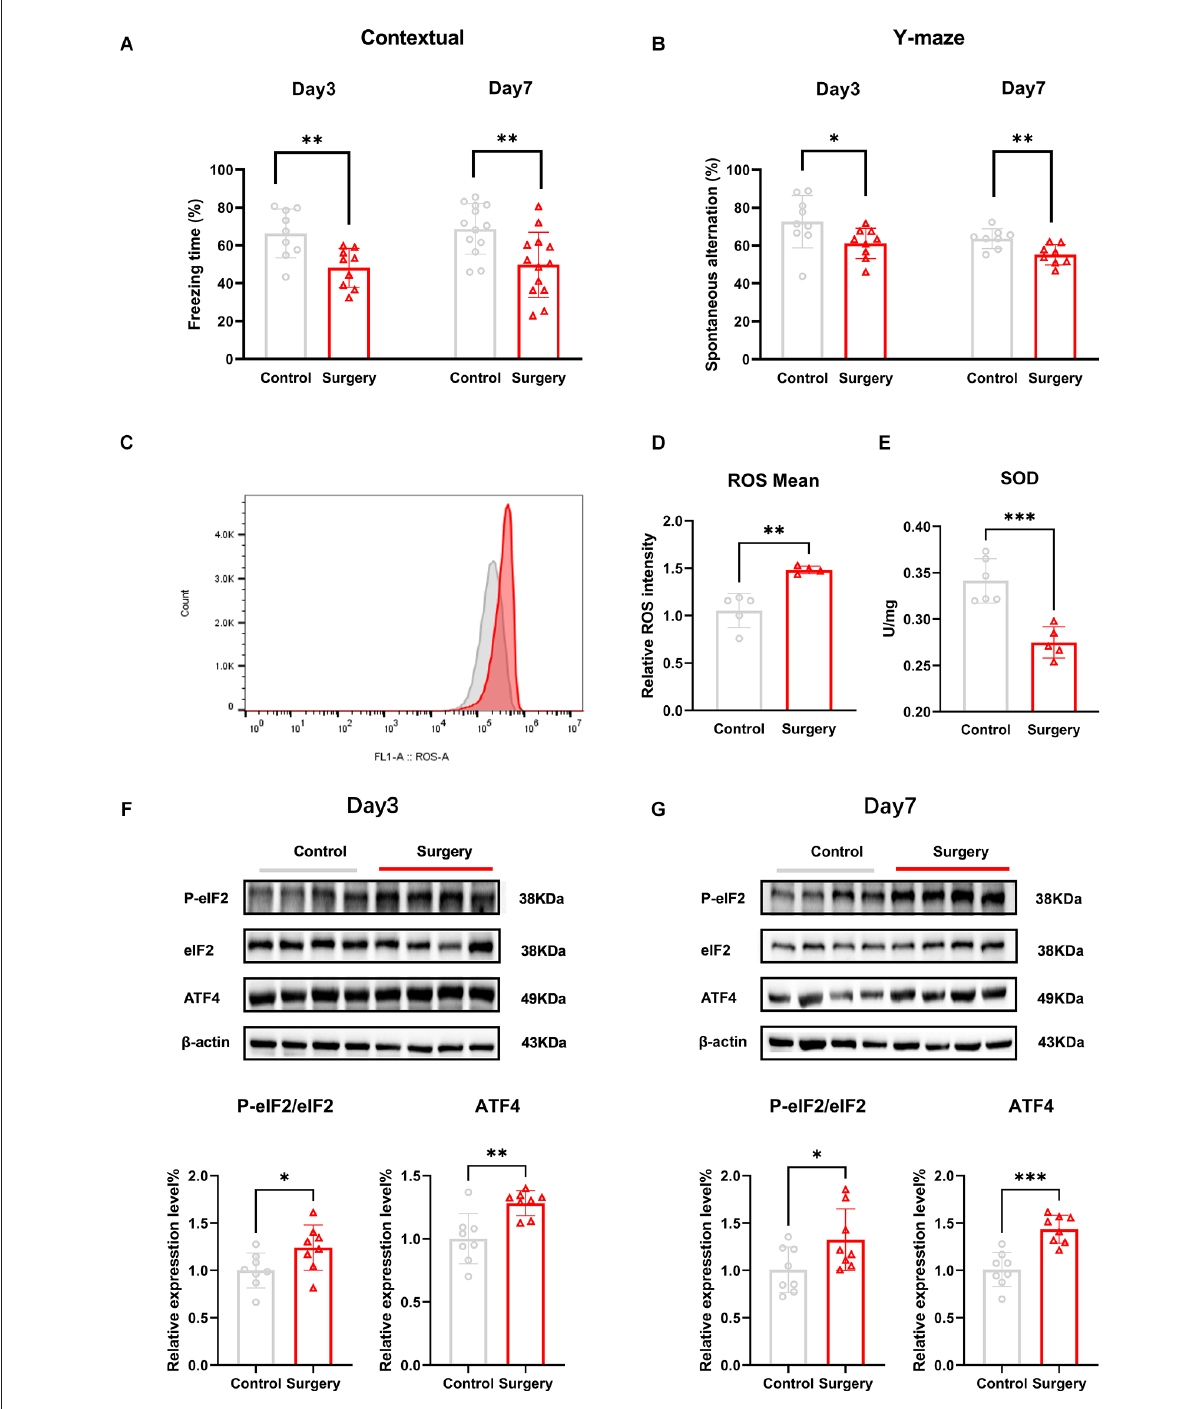
FIGURE1 Tibial fracture surgery induces cognitive decline, accompanied by oxidative stress damage, and ISR activation in the hippocampus of POCD mice. (A) Freezing percentage in the contextual fear conditioning experiment on post-surgery days 3 and 7; the freezing time percentage was significantly reduced in the surgery group compared with the control group. (B) Spontaneous alternation was significantly decreased in the Y-maze on days 3 and 7 following tibial fracture surgery. (C) The average fluorescence intensity of the ROS level increased in the hippocampus of POCD mice on post-surgery day 3, in which red represents the surgery group and gray represents the control group. (D) Histogram quantification of ROS average fluorescence intensity of (C) . (E) The SOD level is decreased in the hippocampus of POCD mice on post-surgery day 3. (F) POCD increased eIF2 α phosphorylation and ATF4 protein levels at post-surgery days 3 and 7 (G) . Data are presented as the mean ± SEM. Student’s t-test was used for statistical analysis. ∗ p < 0.05; ∗∗ p < 0.01; ∗∗∗ p <